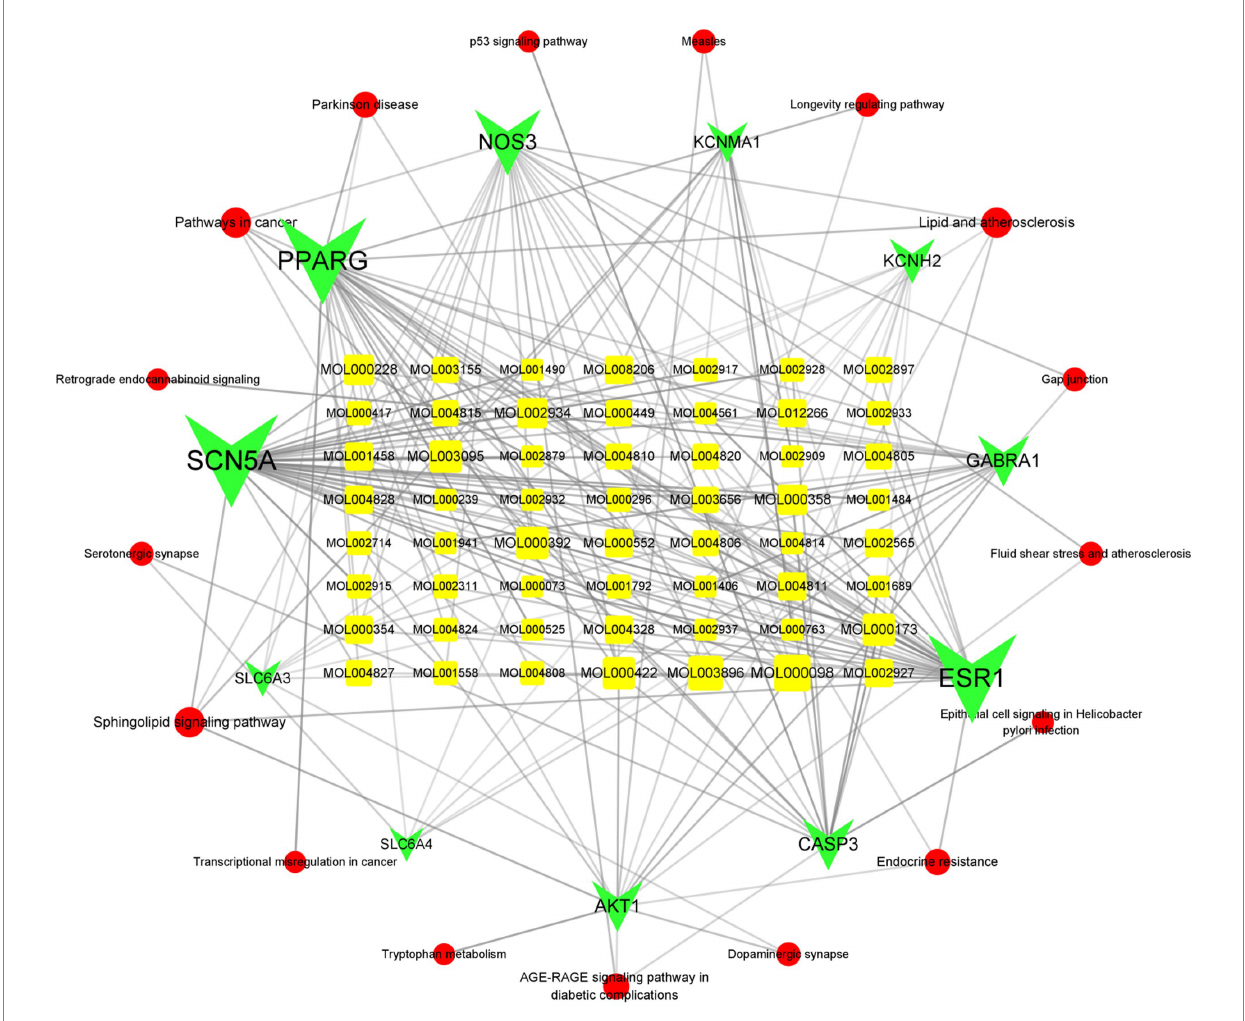
FIGURE 8 Active components–intersection target–signaling pathway network. The circular red color refers to the signal pathways, while the green color corresponds to the targets and the yellow color is the active component. The more lines connected, the stronger the